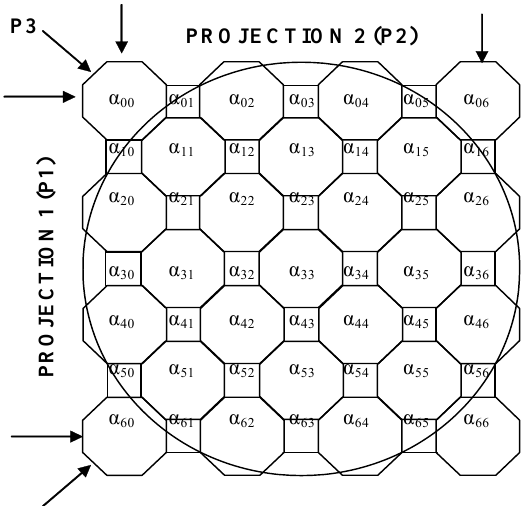
Figure 7. 7 × 7 array of pixels with four